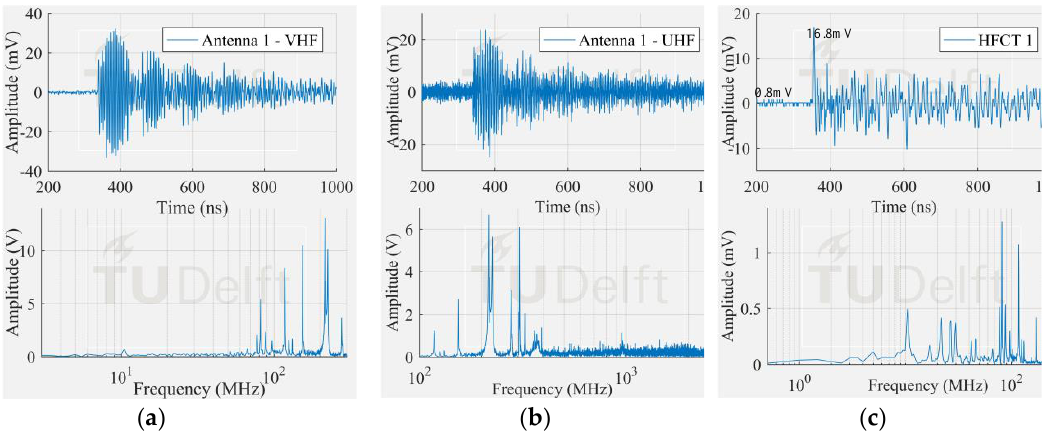
Figure 10. Smallest corona signal measured by ( a ) antenna 1 in VHF; ( b ) antenna 1 in UHF; ( c ) HFCT 1.